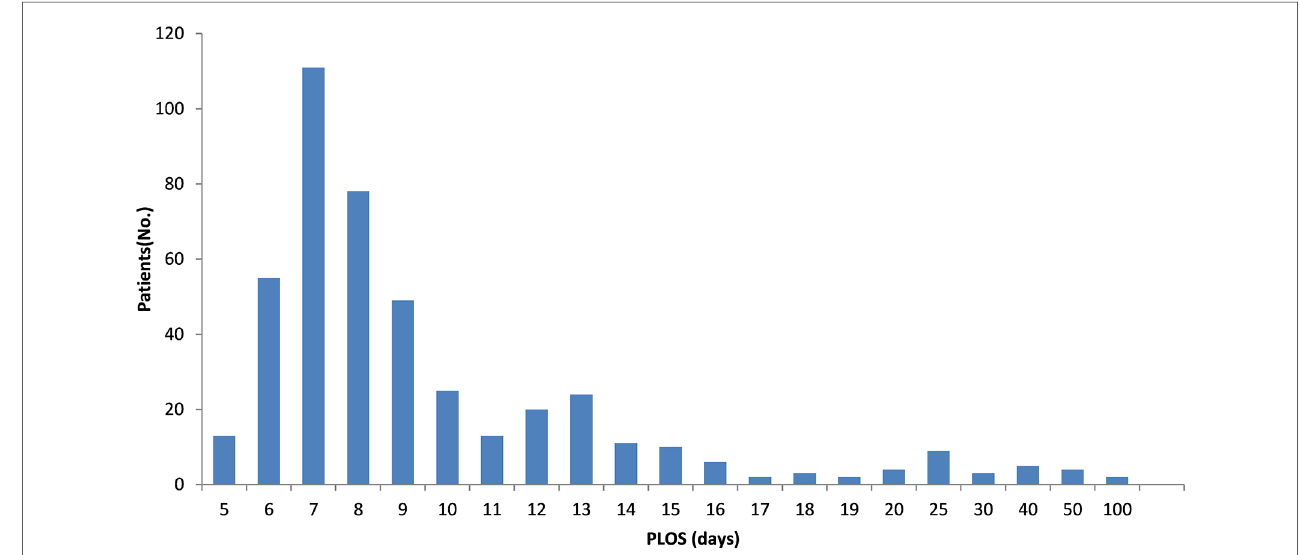
FIGURE 1 Postoperative hospital length of stay, patient distribution. PLOS, postoperative length of stay; Patients (No.), the number of patients;.